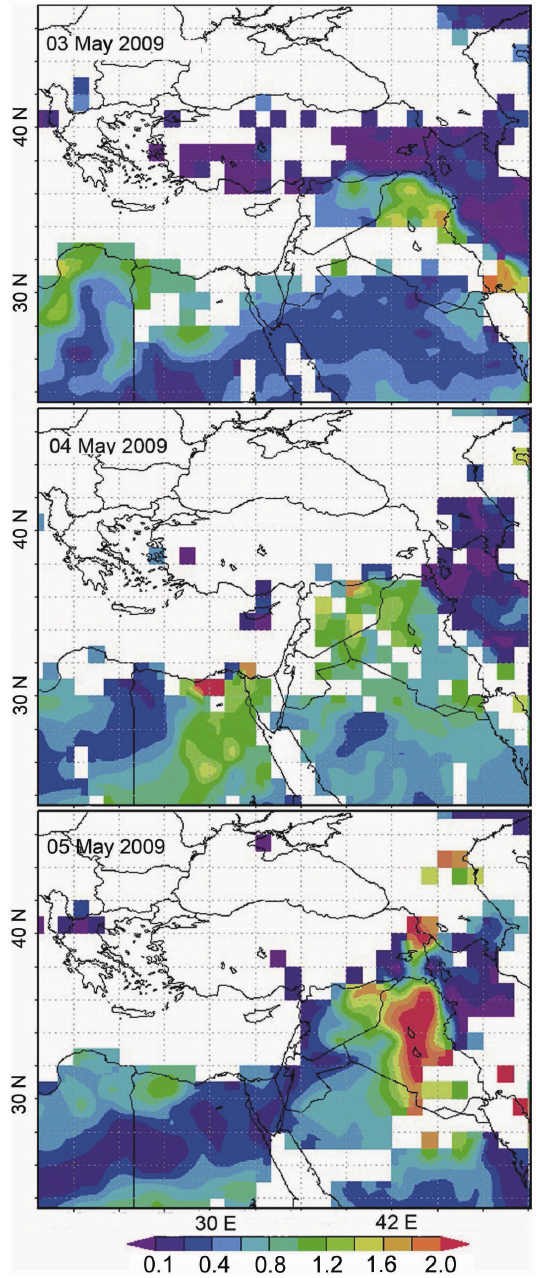
Fig. 3. Aerosol optical depth at 550nm retrieved by the MODIS Deep Blue Level 2 algorithm at about 12:00UTC on (a) 3 May, (b) 4 May, and (c) 5